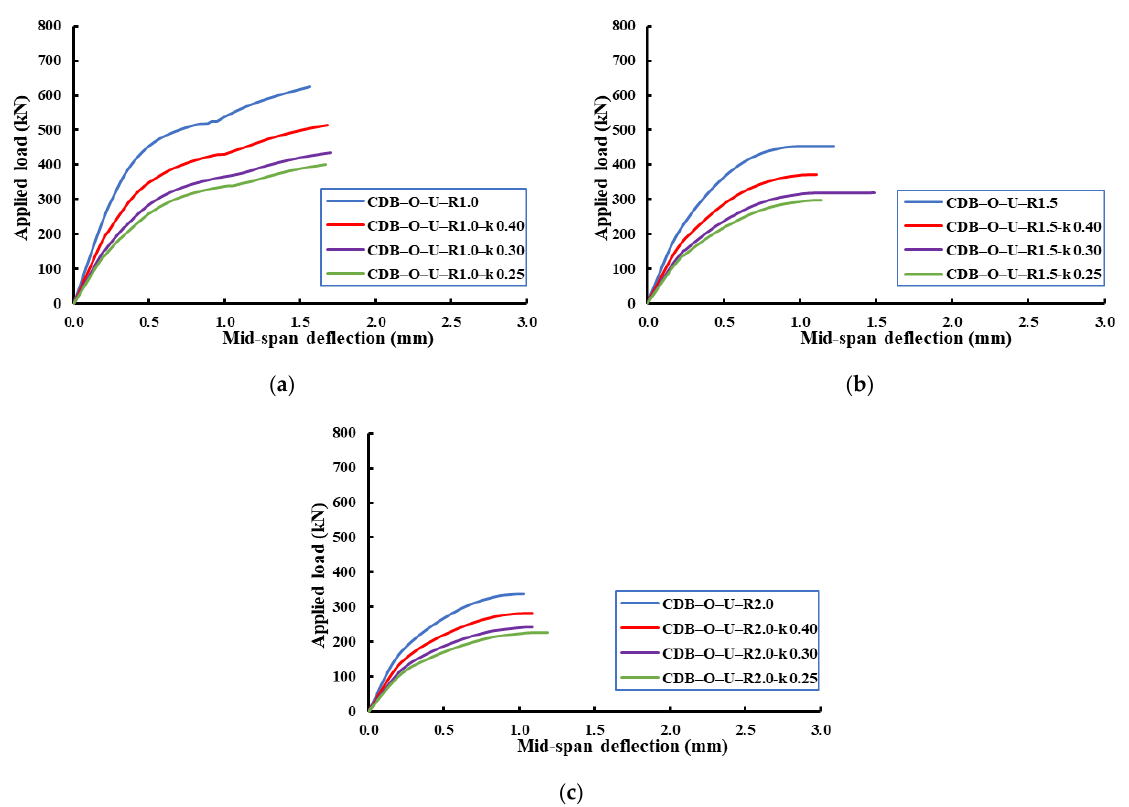
Figure 19. Effect of the load distribution factor on load – mid-span-deflection relationships of the un-strengthened RCCDBs with different ratios of the opening dimensions. ( a ) Opening ratio of 1.0; ( b ) opening ratio of 1.5; ( c ) opening ratio of 2.0.